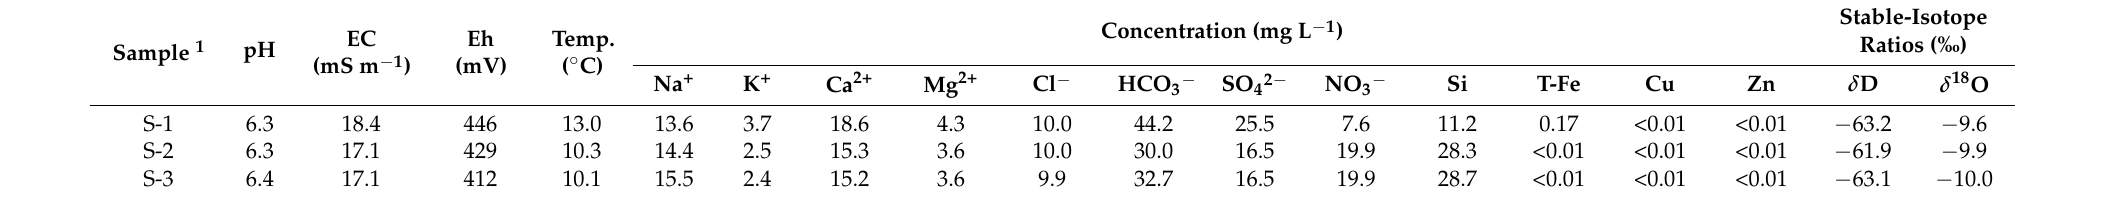
Table 2. Physicochemical properties of water samples collected during 9–11 December